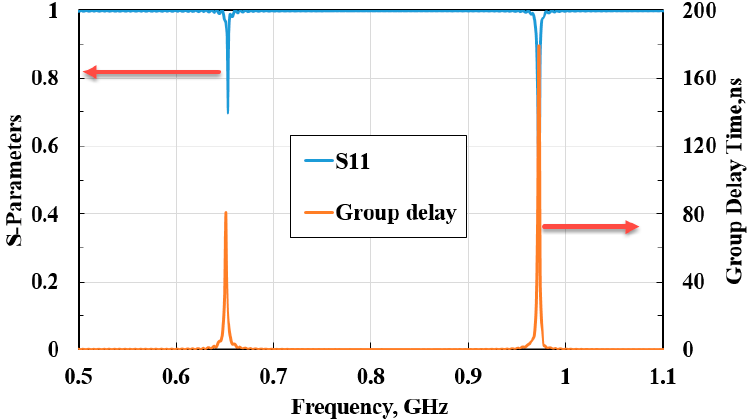
Figure 5. Measurement results.